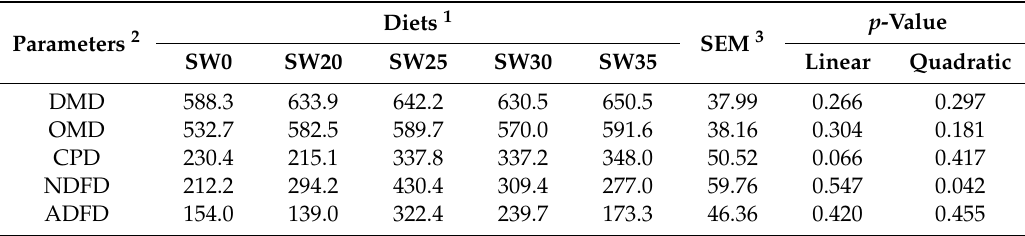
Table 2. Apparent nutrient digestibility (g / kg dry matter (DM), unless stated otherwise) of Boschveld indigenous hens fed seaweed-containing diets.